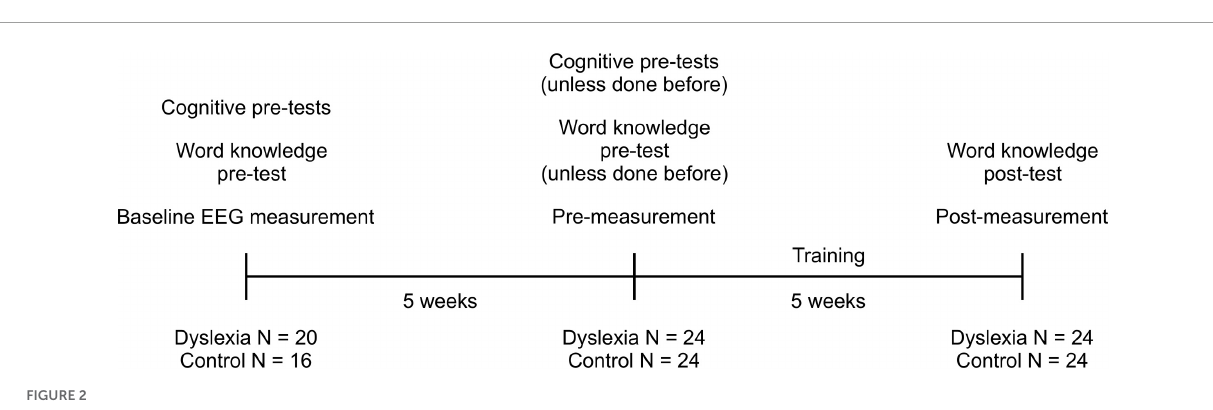
FIGURE2 Timeline of the tests, EEG measurements, and